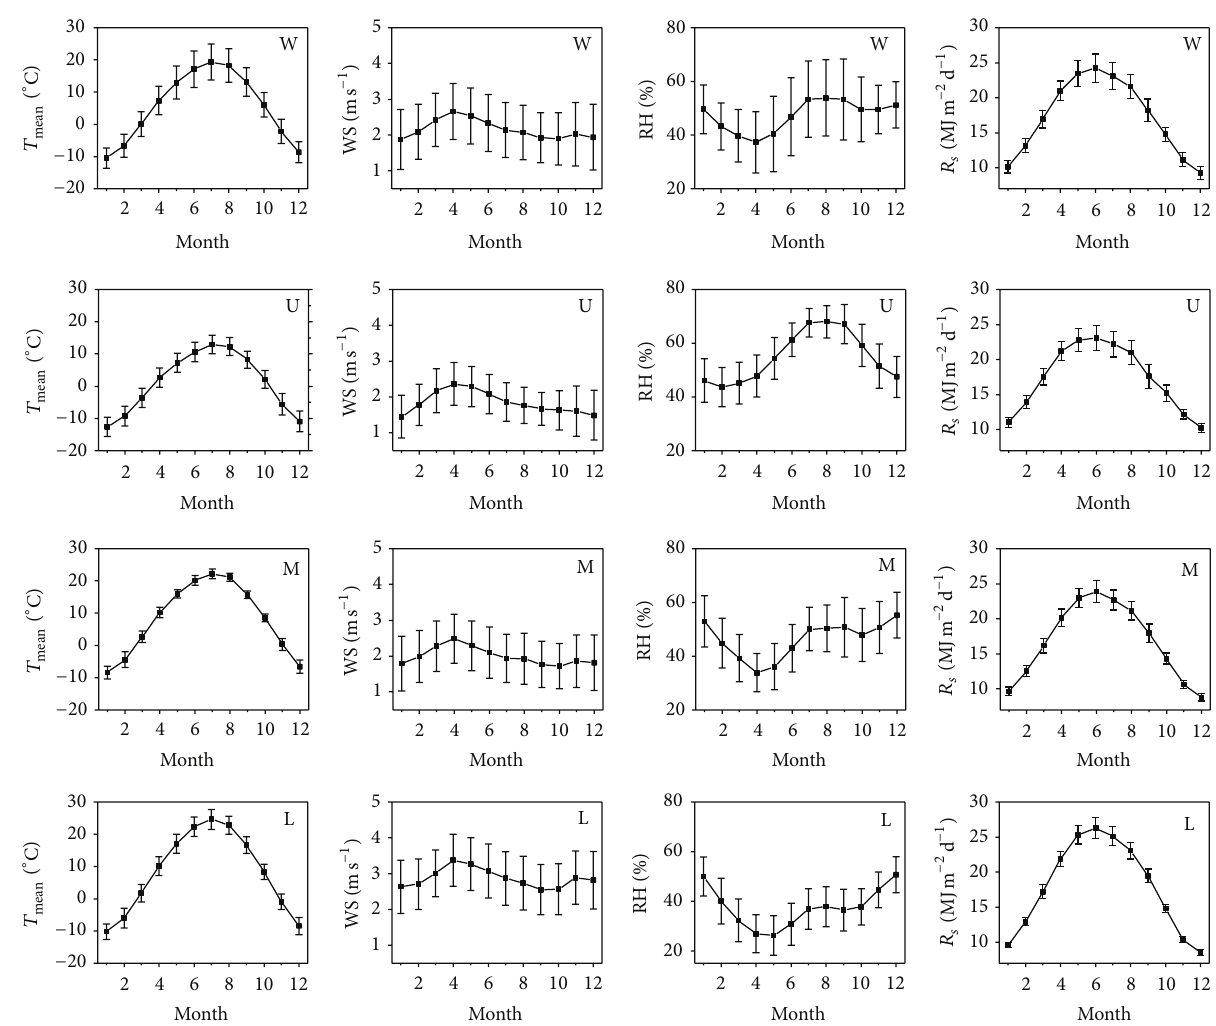
Figure 7: Monthly variations of meteorological factors ( 𝑇 mean , WS, RH, and 𝑅 𝑠 ) in the upper (U), middle (M), and lower (L) regions and the whole basin (W). The 54-year mean (solid line) and standard deviation (error bar) are shown.